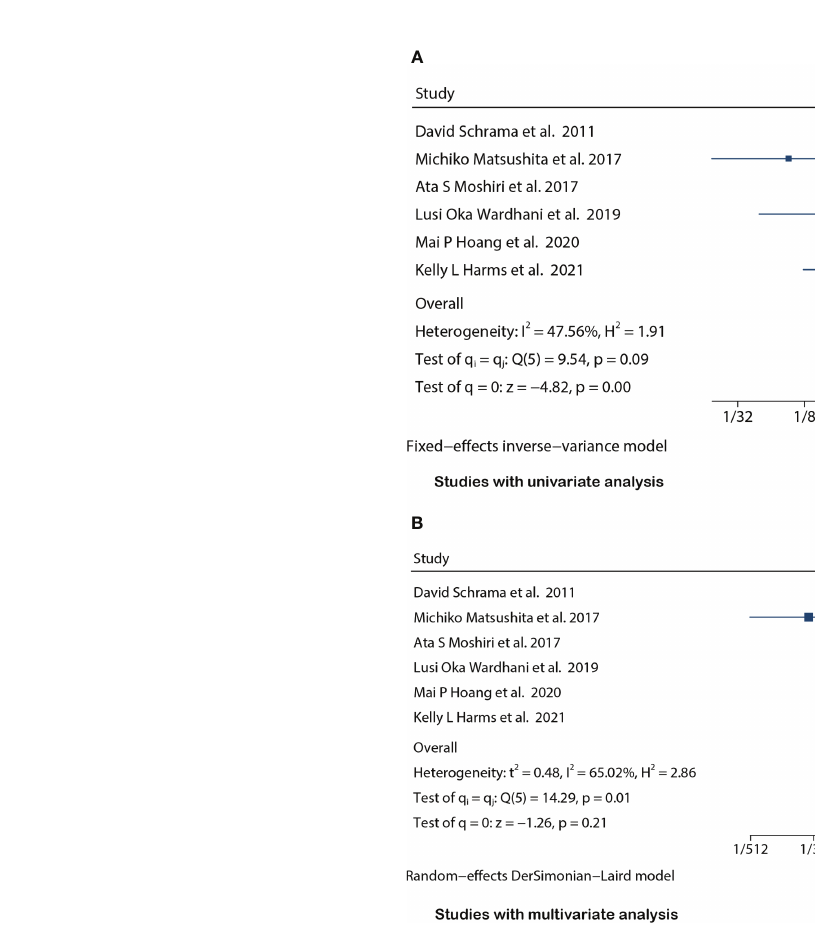
FIGURE 4 Forest plot of the hazard ratio for the association between the MCPyV positivity and MCC-speci fi c Survival(MSS ) in patients with Merkel cell carcinoma. (A) univariate analysis. (B) multivariate